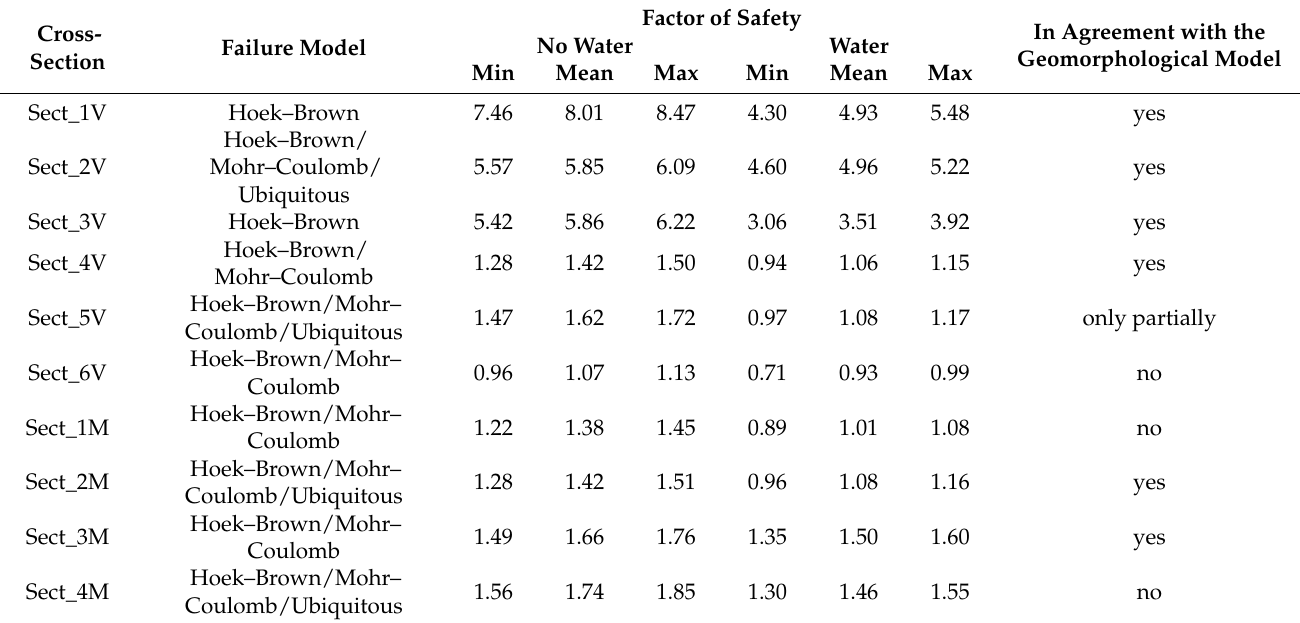
Table 2. Factor of safety resulting from the numerical modeling and correspondence with field evidence.